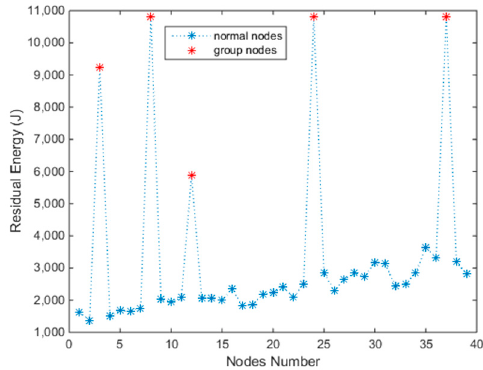
Figure 7. The residual energy of nodes after 391 charging cycles.